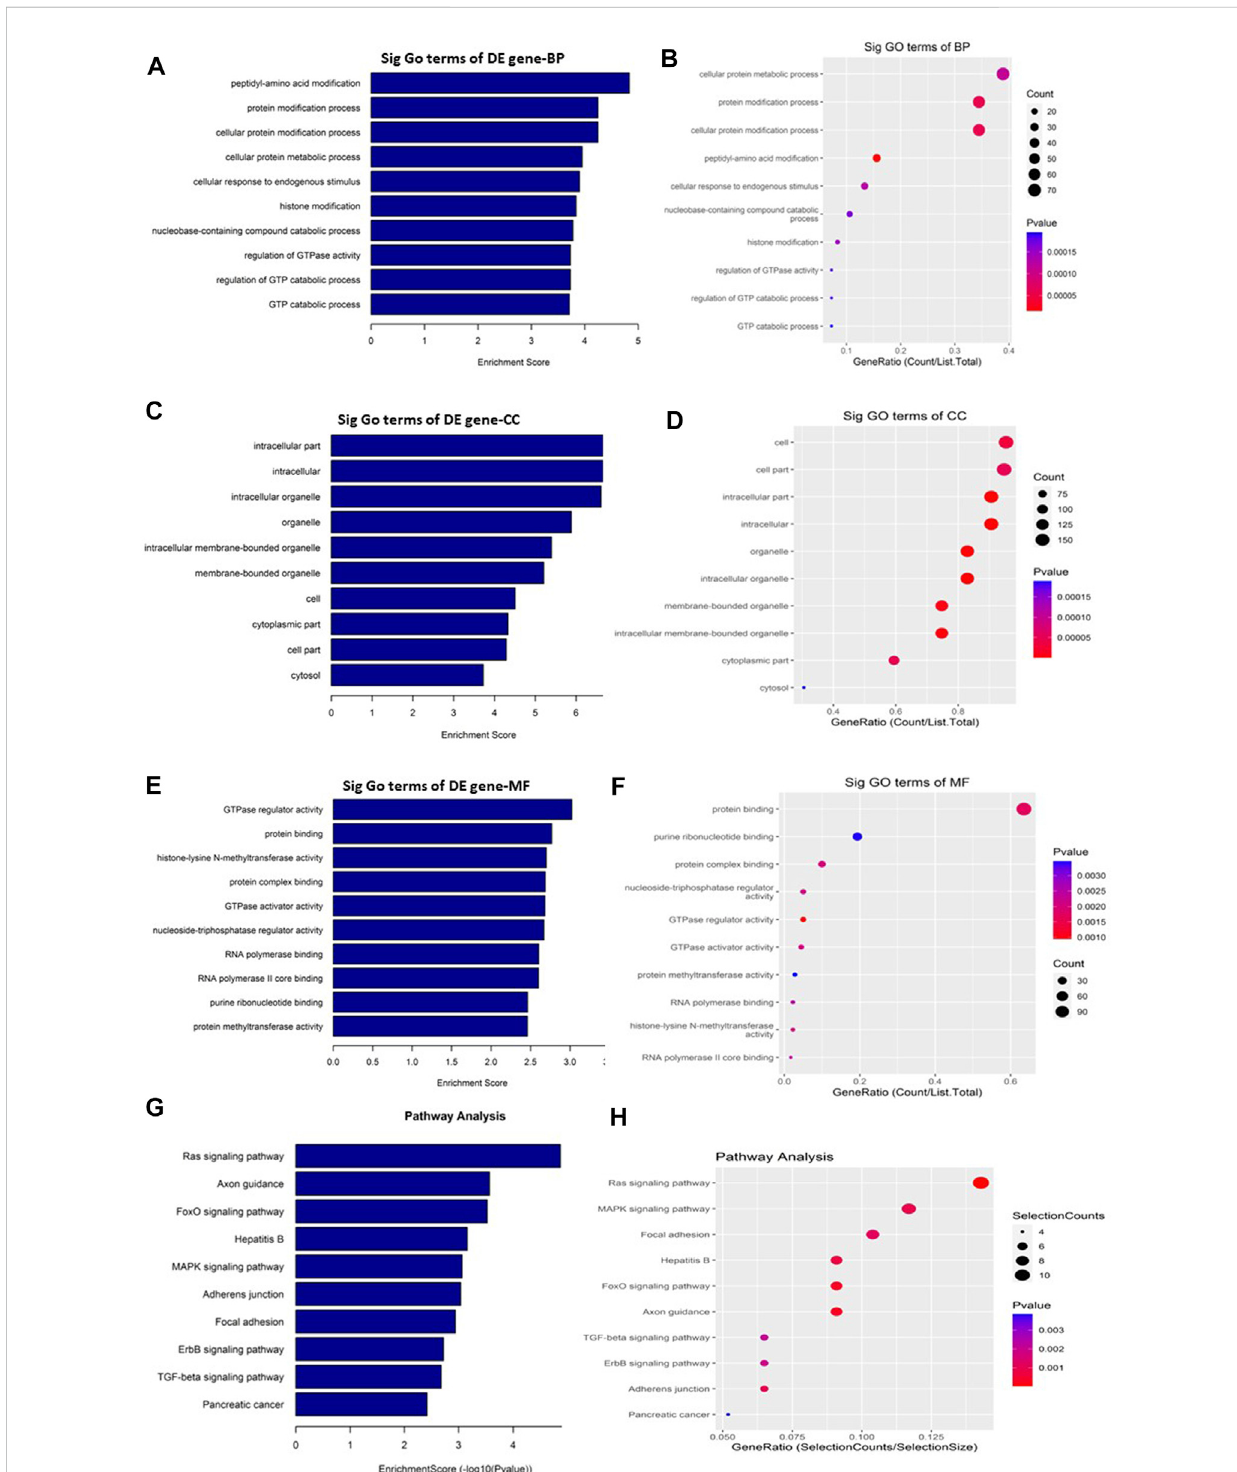
FIGURE 4 Gene Ontology (GO) and Kyoto Encyclopedia of Genes and Genomes (KEGG) pathway analyses of downregulated circRNAs in the GO-AgNPs treatedcaprine fetal fi broblastcells (CFFCs). GOanalysisidenti fi edbiologicalprocess(BP), cellularcomponent(CC)andmolecularfunction(MF)withthe enrichment score [( A,C,E) respectively] and gene count (B,D,F) . The top ten enriched KEGG pathways of signi fi cantly altered circRNA genes (G,H) . The color intensity of the nodes shows the degree of enrichment of this analysis. The enrich-factor is de fi ned as the ratio of the differential genes in the entire genome. The dot size represents the count of genes in a